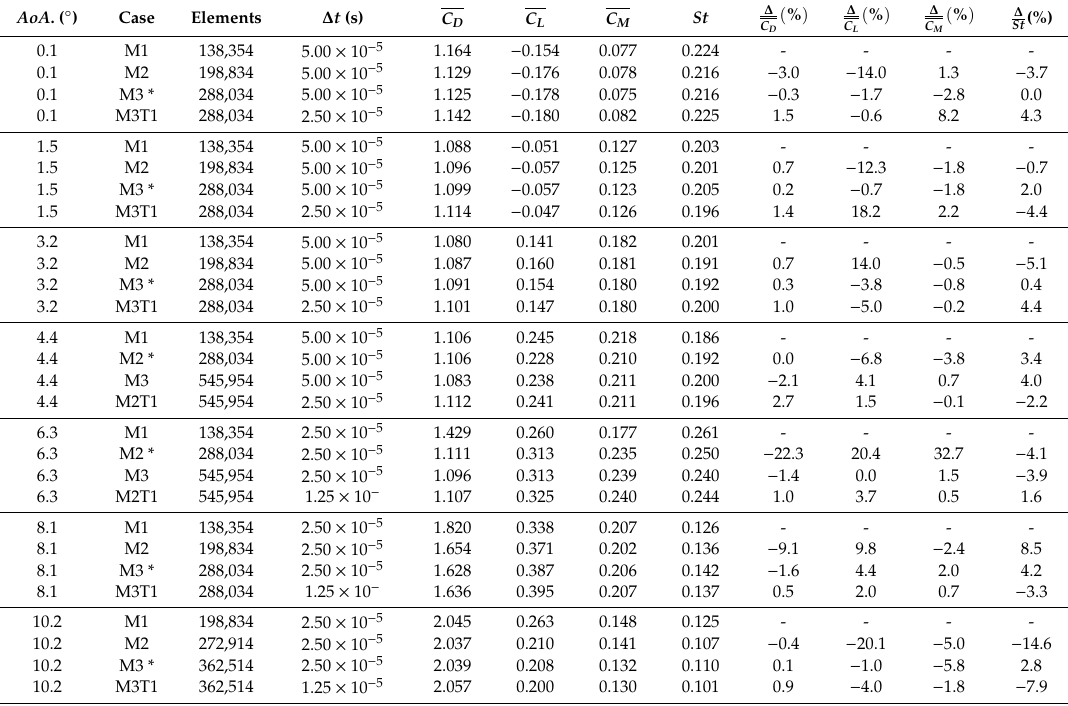
Table 1. Aerodynamic properties for di ff erent grid and time resolutions for AoA > 0 ◦